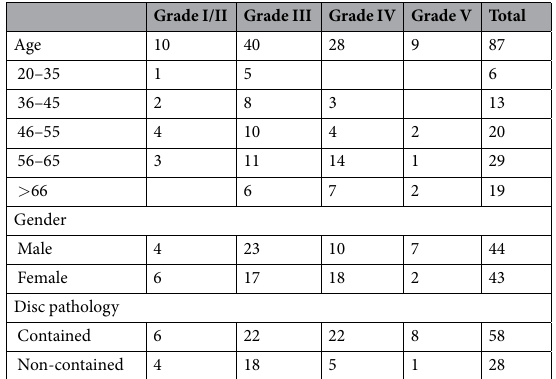
Table 2. Spinal levels and clinical pathology of the study